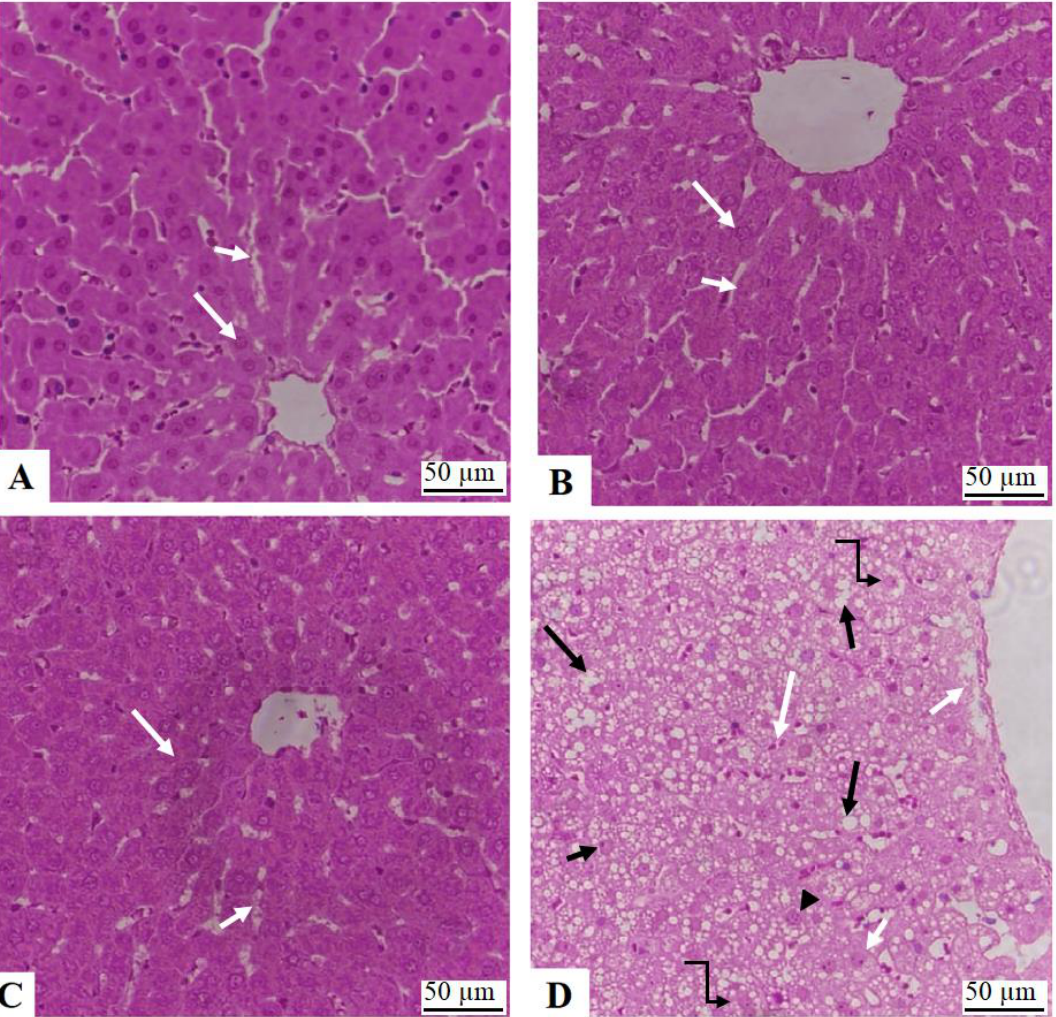
Figure 5. Liver histology sections from control groups and HFD model rats. ( A – C ): were taken from control, NAC, and + γ -oryzanol-treated animals, respectively, and showed normal liver pathology, including normal central vein (CV) in which normally appearing hepatocytes are radiating (long white arrow). In addition, these cells had normally sized sinusoids (short white arrow). ( D ): was taken from an HFD-fed animal and showed a typical image of liver steatosis. The CV was greatly enlarged with evidence of some cell necrosis around it (short white arrow). The majority of the cell cytoplasm was filled with fat droplets (long black arrow). In addition, karyolysis (black arrowhead), pyknosis (short arrow), and karyorrhexis (short black arrow) in a majority of the hepatocytes (curved black arrow) were dominant and in large numbers. Immune cell infiltration was also seen (large white